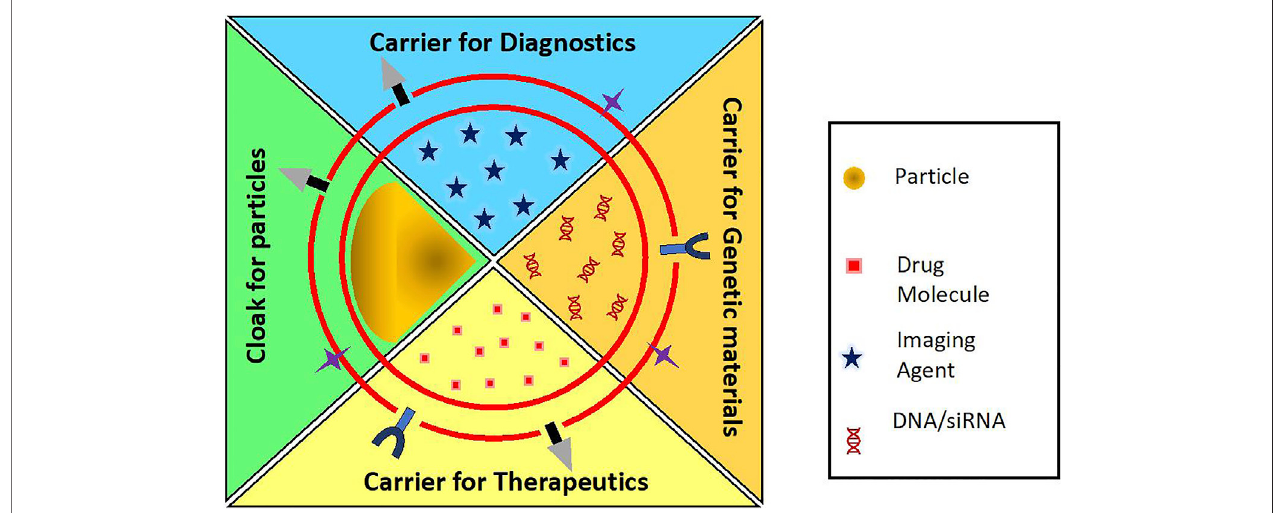
FIGURE 5 | Applications of RBC carriers and RBC-camou fl aged systems as carriers for diagnostics, genetic materials, therapeutics, etc.